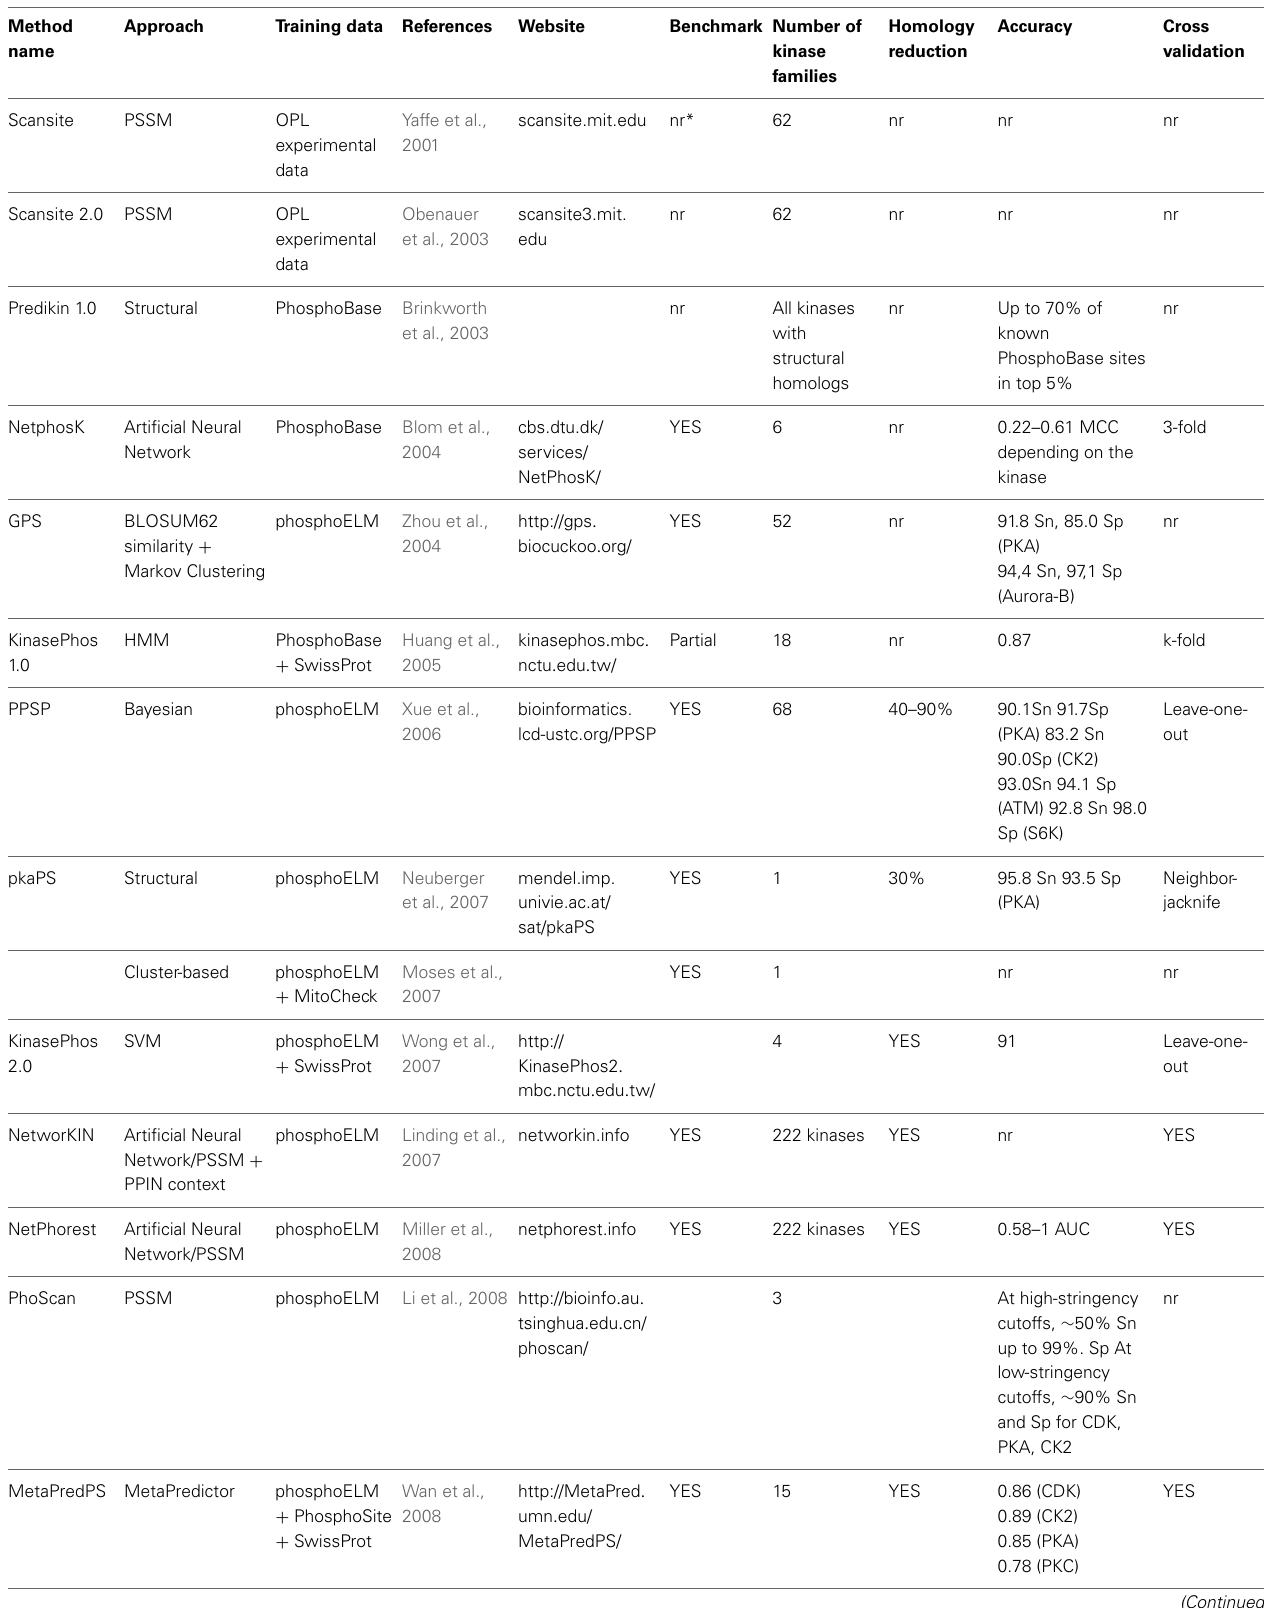
Table 1 | Computational methods for kinase-specific phosphorylation site